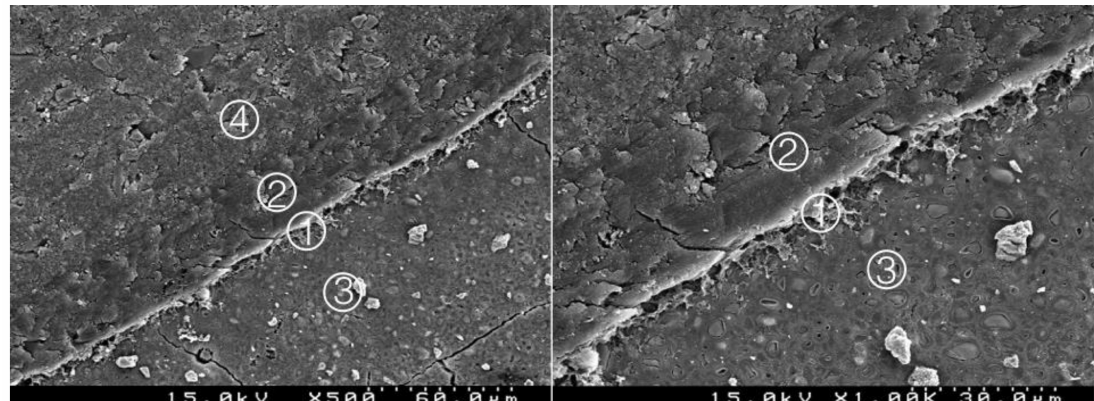
Figure 4. Group 2 (BiodentineSE07): hybrid layer with some empty spaces corresponding to the removed inorganic superficial content of the CSC and some deeper content of the adhesive. A remaining organic mesh of the adhesive in the hybrid layer is shown 1 (cid:13) . Adhesive 2 (cid:13) , Biodentine TM 3 (cid:13) , composite resin 4 (cid:13) (original magnification 500 × and 1000 × ).